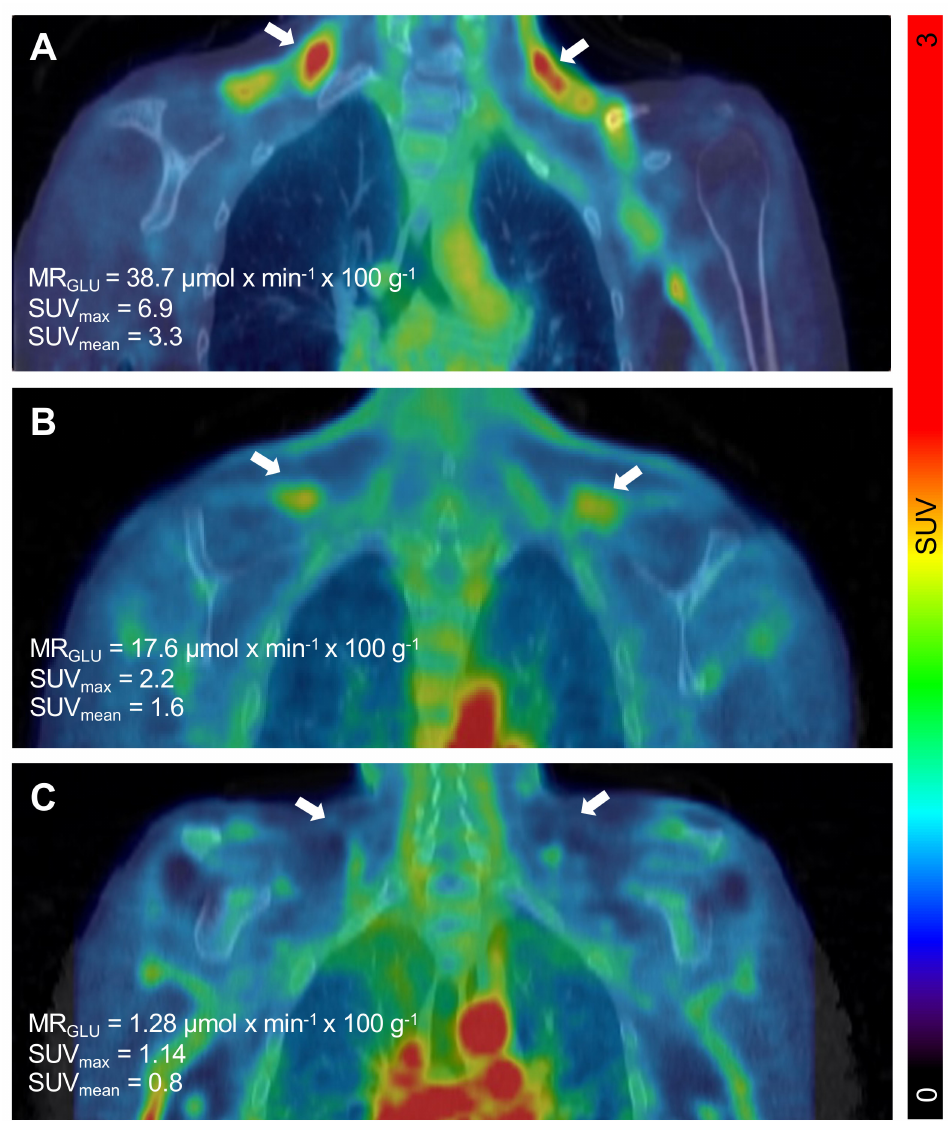
Figure 2. Detection of a wide range of metabolically active brown adipose tissue (BAT) in subjects with T1D. Cold-induced metabolic activity of BAT was measured by dynamic 18 F-FDG PET / CT individuals with type 1 diabetes. Representative coronal PET / CT image projections of individuals with high (38.7 µ mol × min − 1 × 100 g − 1 ) ( A ), intermediate (17.6 µ mol × min − 1 × 100 g − 1 ) ( B ), or low ( µ mol × min − 1 × 100 g − 1 ) ( C ) amounts of metabolically active BAT deposits. Left and right deposit of BAT is indicated by white arrows in all images. The scale bar to the right shows the colour coding from SUV 0 to